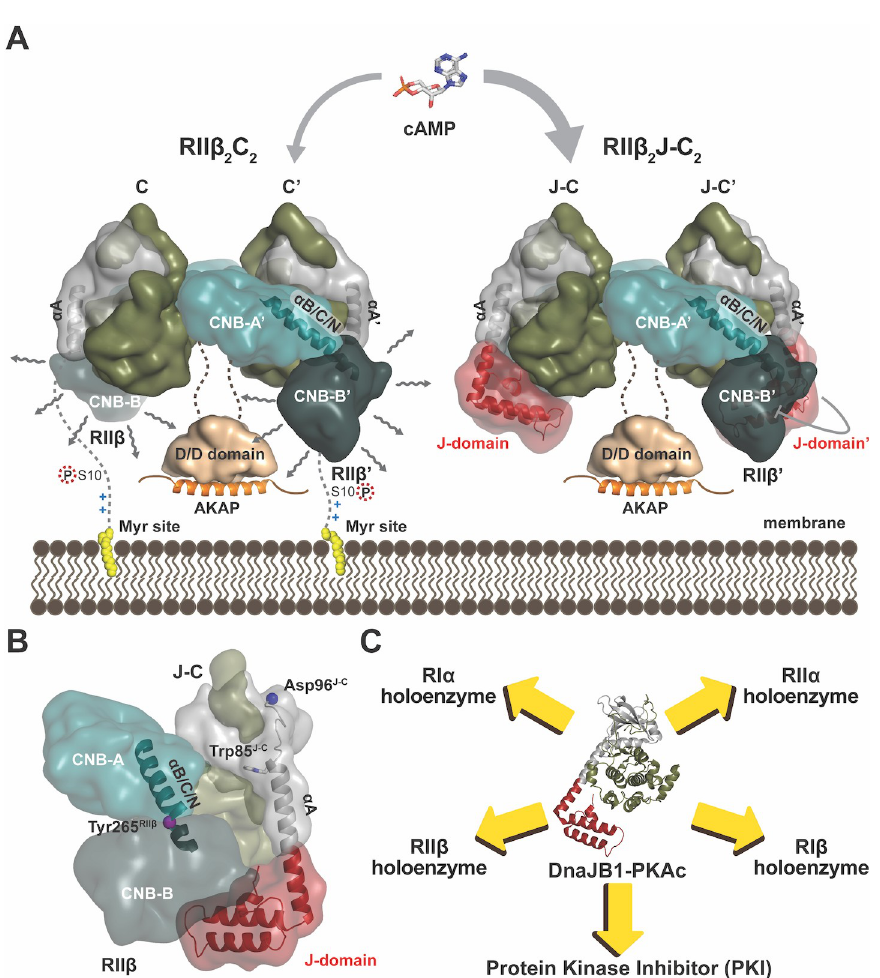
Fig 6. The structural, dynamic, and allosteric features of RII β 2 J-C 2 holoenzymes. ( A ) The J-domain disrupts the multivalent interaction, and it can also stabilize the CNB-B domain dynamic in RII β holoenzyme. Meanwhile, RII β 2 J-C 2 holoenzyme is easier to be activated by cAMP than RII β 2 C 2 holoenzyme. ( B ) Two helices, B/C/N-helix and A-helix, regulate the RII β holoenzyme allostery. ( C ) DnaJB1-PKAc impairs PKA signaling network in an isoform- specific manner. CNB, cyclic nucleotide binding; PKA, cAMP-dependent protein kinase; PKI, protein kinase inhibitor. contribute to membrane anchoring [47]. As we show here, ordering the first 14 residues in the membrane-bound holoenzyme could easily affect the dynamic behavior of the entire WT holo- enzyme. The hydrophobic carboxyl terminus of the RII β subunit, as well as its dynamic β 4- β 5 loop in the CNB-B domain, could also become ordered when the holoenzyme is anchored to membranes. The highly basic β 4- β 5 loop in RII β is, in particular, in close proximity to the acidic surface of the membrane (Fig 6A). In addition, AKAPs themselves typically have a membrane- targeting motif (MTM), so many mechanisms could be used to stabilize interactions with mem- branes (Fig 6A). In the J-C fusion protein, the myristylation site is lost which could also affect, although not necessarily abolish, RII β holoenzyme binding to membranes in cells (Fig 6A). Two helices drive the allosteric regulation of the PKA holoenzymes There are 2 helices that drive the allosteric regulation of PKA, the B/C/N-helix in the R sub- units and the A-helix in the C subunit (Fig 6B). Sequences difference in the B/C/N-helix, as